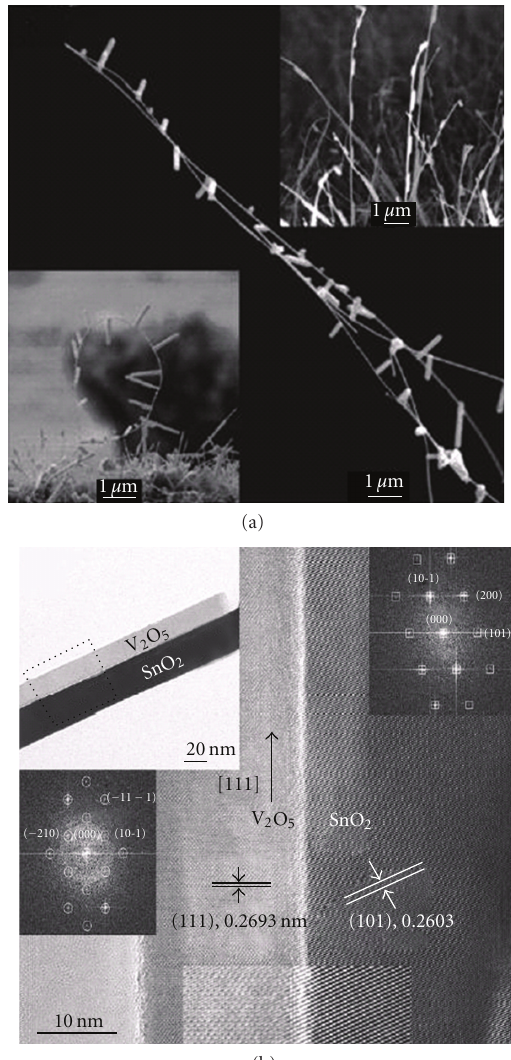
Figure 4: SEM and TEM images of SnO 2 -V 2 O 5